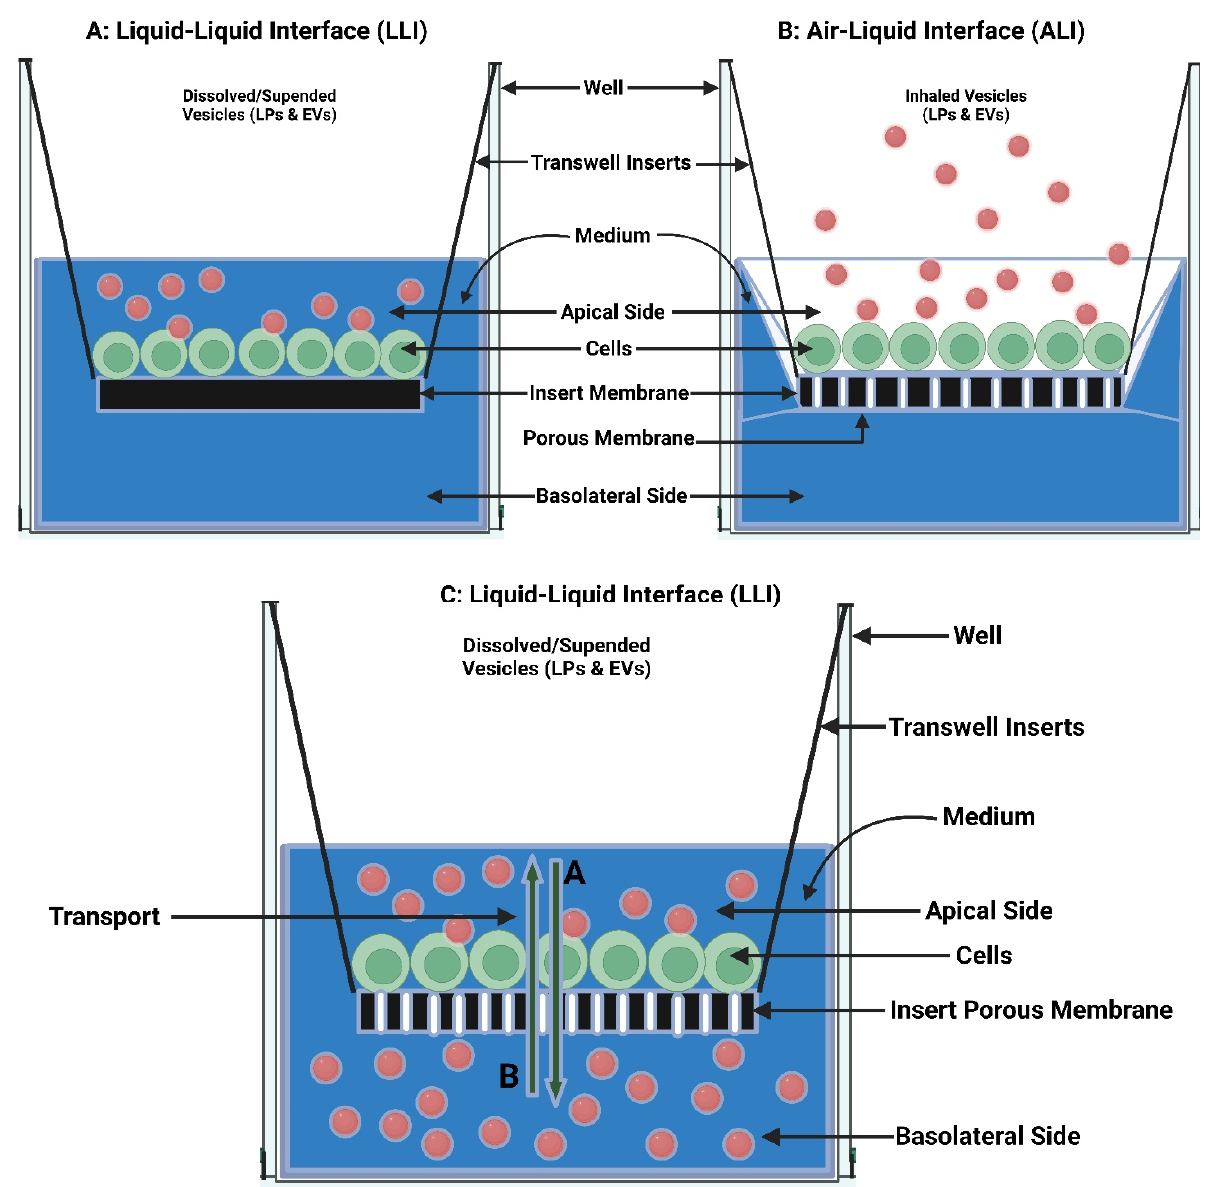
Figure 13. Schematic representation of cell exposure models employed for studying cells-vesicles interaction: ( A ) Liquid-liquid interface (LLI). ( B ) Air-liquid interface (ALI). ( C ) Liquid-liquid interface (LLI) includes a porous membrane.